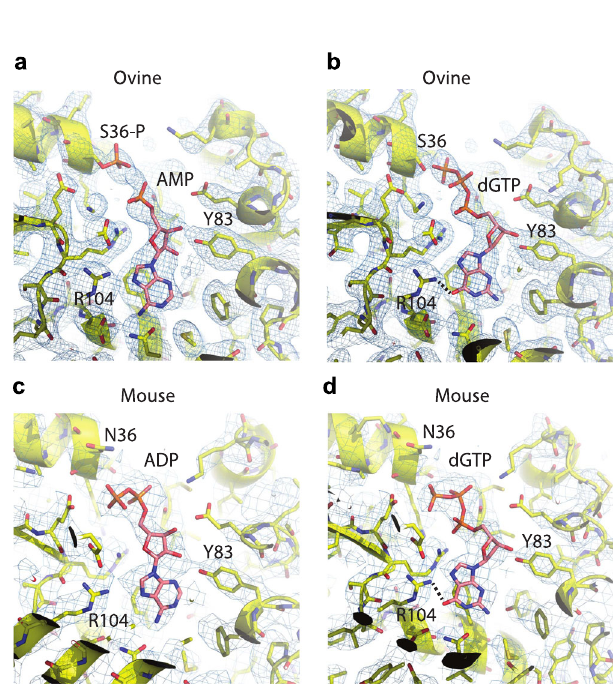
Fig. 4 Putative mode of dGTP binding to mammalian complex I. a , c Cryo- EM maps and models for ovine (PDB 6ZKA, 2.5 Å resolution) and mouse (PDB 6g2j, 3.3 Å resolution) complex I. Cryo-EM density is shown as a blue mesh. b , d Putative models of dGTP fi t into the same density. Key residues discussed in the text are